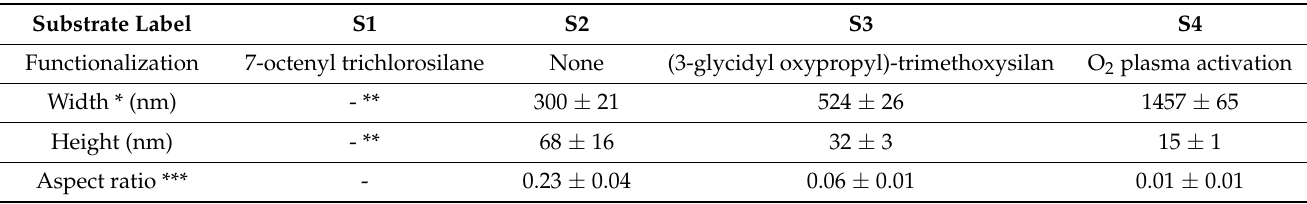
Table 1. Height of adhesive lines printed on differently functionalized